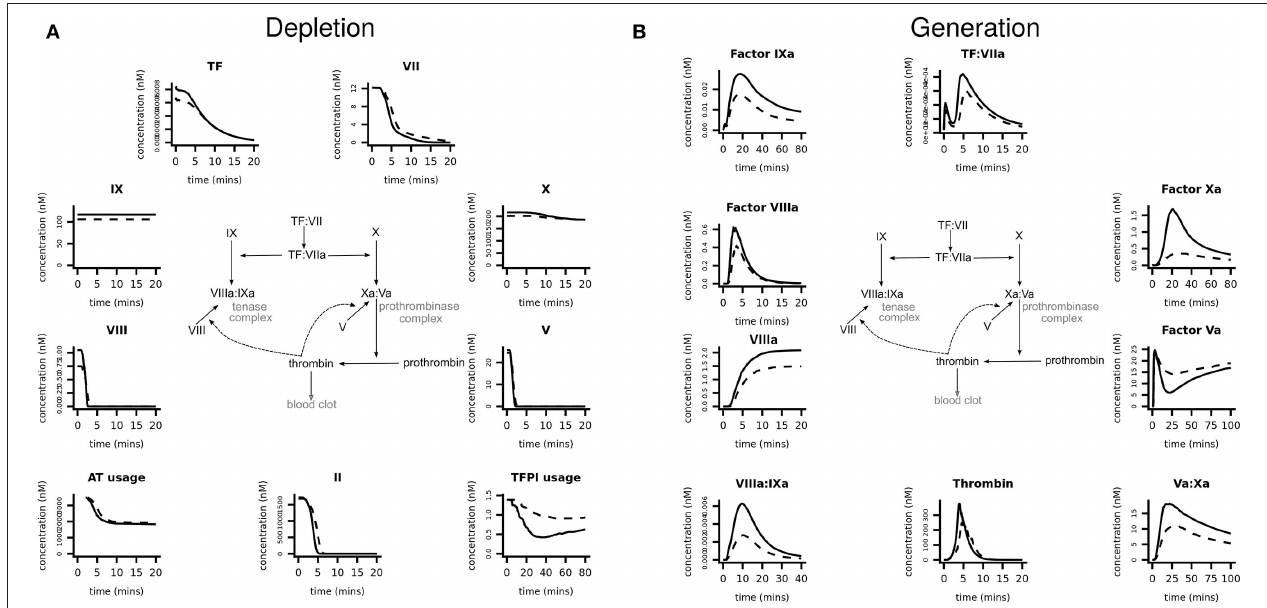
FIGURE 3 | Prediction of coagulation protein depletion and generation in premature MI subjects vs. healthy donors. Computer simulations were generated, using the plasma protein values as inputs, to predict (A) the depletion and (B) the generation of coagulation proteins. Each graph shows the median simulated response predicted, specific to each coagulation protein or complex, for the populations of pMI subjects (solid lines) and healthy donors (broken lines). These data are provided in more detail in Supplementary Figures SII , SIII which show the median and 5% and 95% confidence